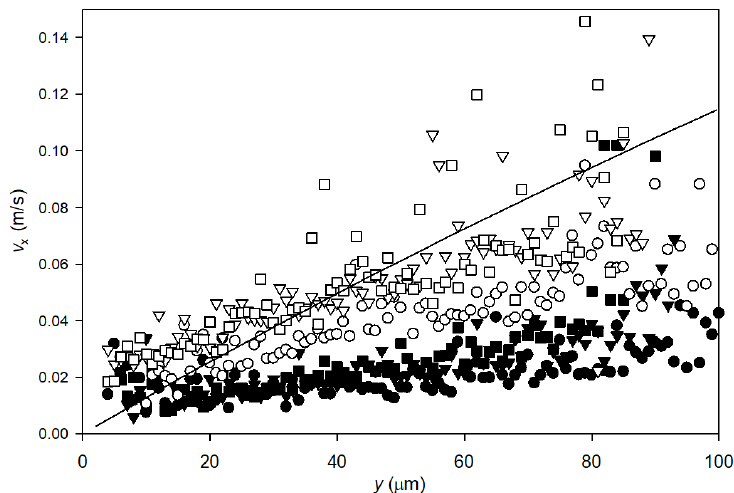
Figure 8. Speed of highly charged particles along the membrane surface plotted against particle distance from the membrane surface. The points (cid:4) , • and (cid:72) represent velocities of particles recorded at a crossflow velocity of 0.13 m / s while (cid:3) , and ∇ are obtained from particles recorded at 0.33 m / s crossflow velocity. For each crossflow velocity, three recordings were conducted during membrane filtration at TMP = 2 bar. The line represent modelled water velocity along the membrane fiber at 0.33 m / s crossflow velocity and 2 bar TMP using